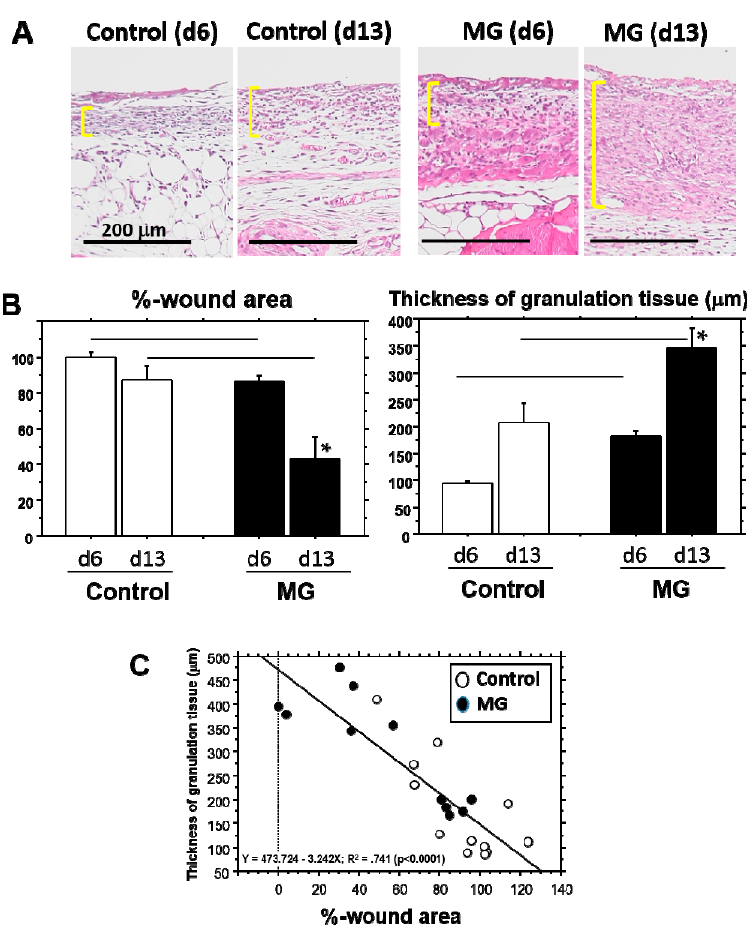
Figure 6. Wound area and thickness of granulation tissue. ( A ) The representative pictures of granulation tissue marked by yellow lines indicate Days 6 and 13 in control and MG groups. Scale bar = 200 µ m; ( B ) %-wound area ( left panel ) and thickness of granulation tissue ( right panel ) were compared on Days 6 and 13 between control and MG groups. * p < 0.05 within the groups; line: p < 0.05 between the groups; ( C ) Regression analysis was performed between %-wound area and thickness of granulation tissue.